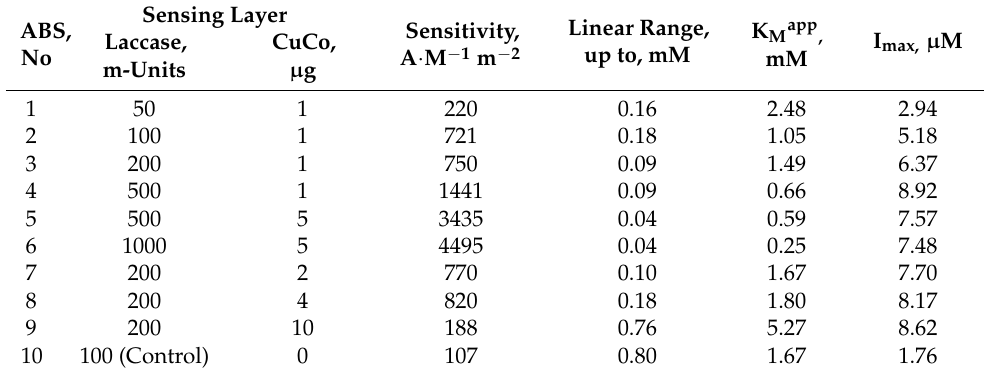
Table 2. Analytical properties of the ABS as the dependence on the composition of the sensing layer.